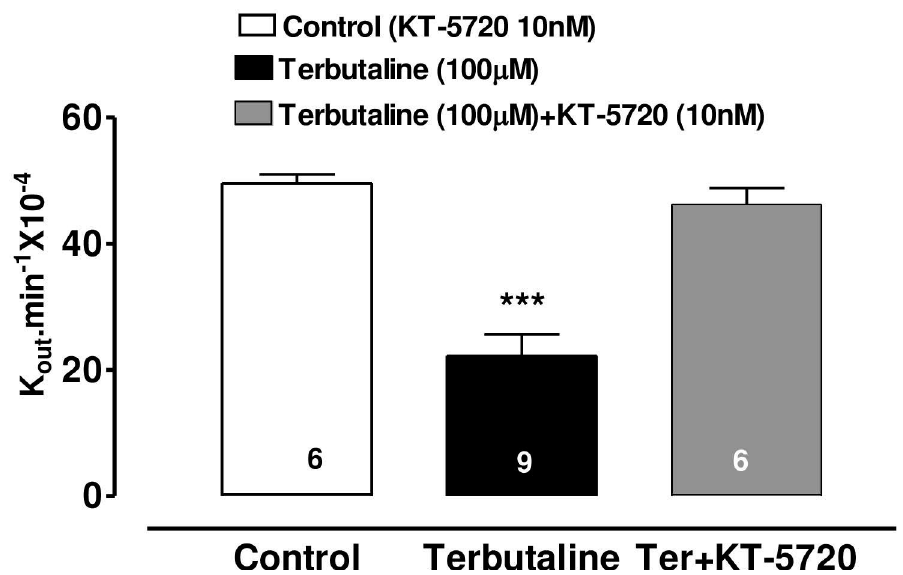
Fig 4. Effect of KT-5720 (10nM) on the inhibitory effect of terbutaline (100 μ M) on AH formation in the bovine perfused eye. Stock solution of the PKA inhibitor (KT-5720) in DMSO was added to the perfusate to obtain a final concentration of 10 nM. AH formation rate (shown as K out .min -1 10 − 4 ) was measured in separate groups of eyes for 90 min after injection of vehicle or drug. Each value is a mean s.e.mean of the number (n) of experiments shown at the base of each column. Control: injection of vehicle and PK inhibitor. Significance of difference from control; ��� p < 0.001.